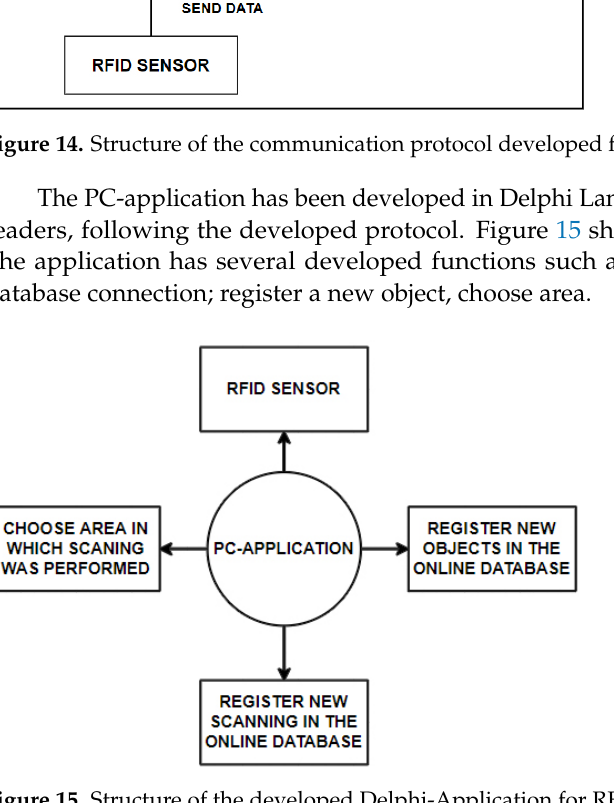
Figure 14. Structure of the communication protocol developed for RFID-reader.